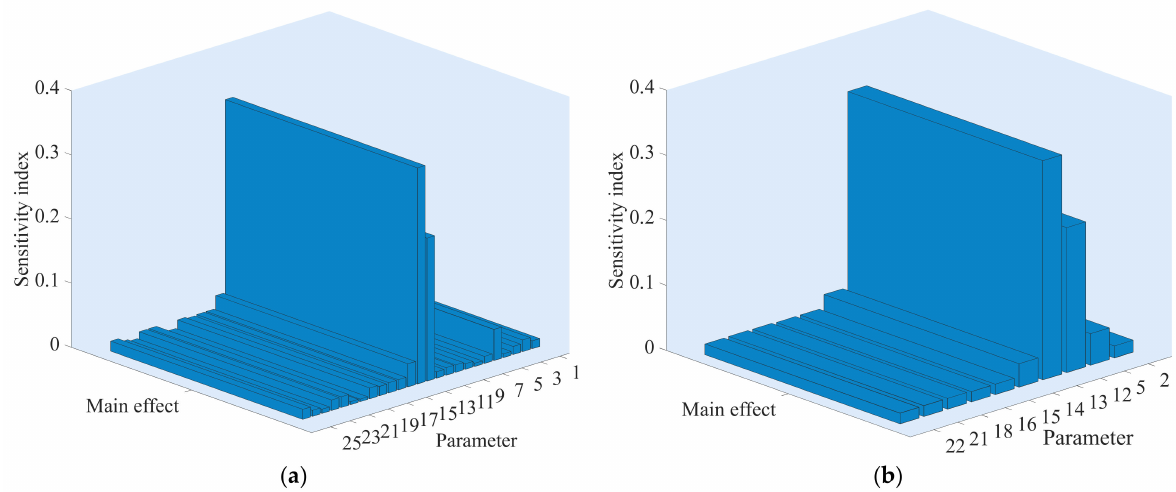
Figure 16. The sensitivity index of parameters of the settling time of the angular velocity. ( a ) The sensitivity index of 25 parameters; ( b ) The sensitivity index of the top 10 parameters. The numbers 1 to 25 represent symbols T , Kp , b p , K d , A t , D t , f p , q nl , T 0 , T d0 , T d00 , T q00 , H , F , K a , R s , L ls , R r , L lr , L m , H 1 , F 1 , WS , Ncellm12 and I r , respectively. For the physical meaning and definitions of these parameters, see Appendix